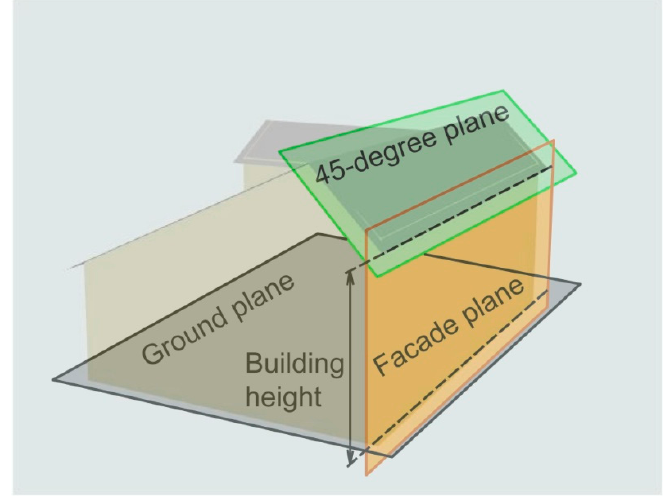
Figure 2. The three planes used to calculate the building height.